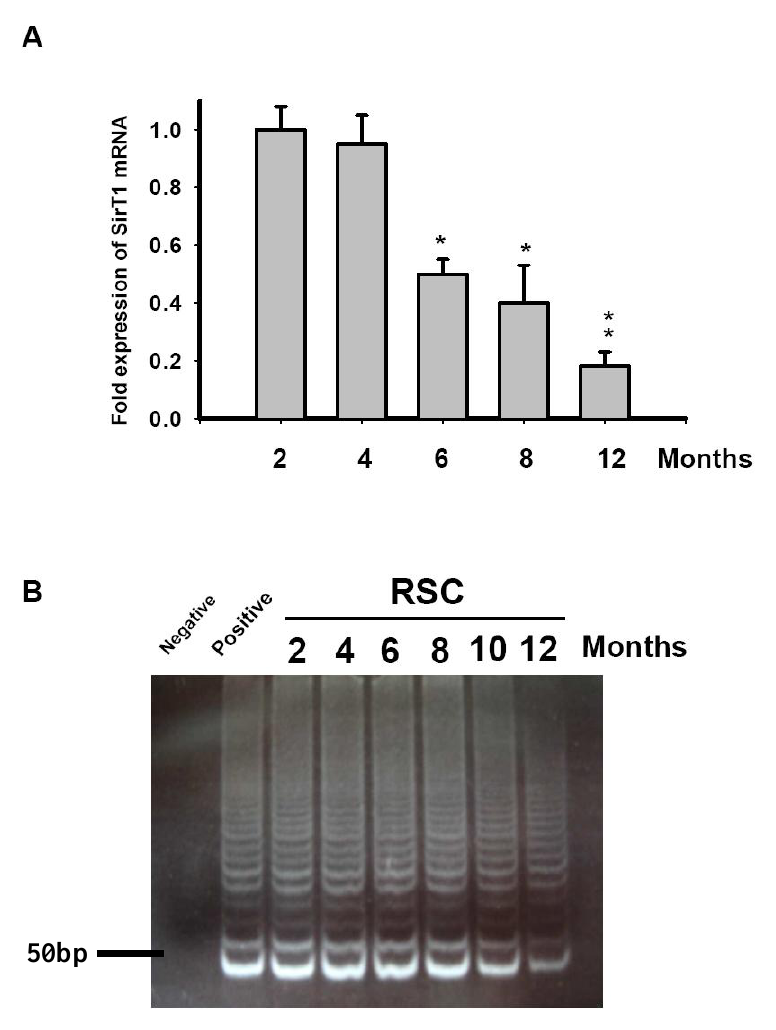
Figure 2. Detection of SirT1 mRNA and telomerase activity in rat RSCs.(A) The amount of SirT1 mRNA was detected by Q-PCR from RSCs of SD rats of different ages, and. *p < 0.05; **p < 0.01 versus 2- and 4-month-old RSC groups. Data shown here are